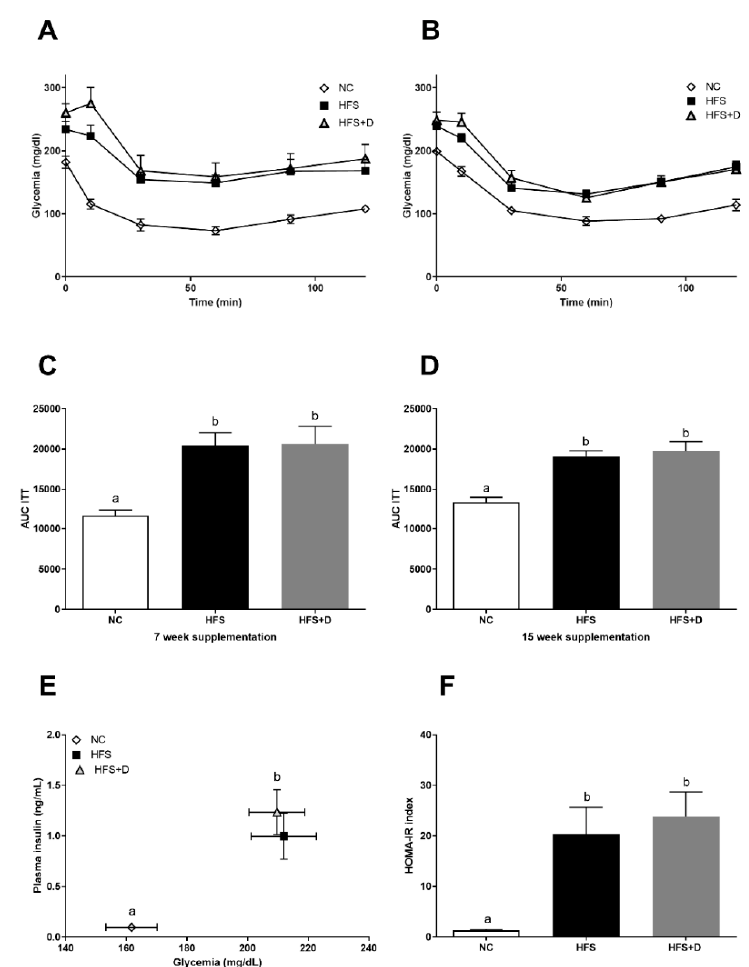
Figure 2. E ff ects of vitamin D (VD) supplementation on glucose homeostasis. ( A ) Glycemic response to insulin injection after 7 weeks of VD supplementation. ( B ) Glycemic response to insulin injection after 15 weeks of VD supplementation. ( C ) Area under the curve (AUC) calculated from the glycemic response curve after 7 weeks of VD supplementation. ( D ) AUC calculated from the glycemic response curve after 15 weeks of VD supplementation. ( E ) Quantification of plasma glucose and insulin at the end of the 25-week protocol. ( F ) HOMA-IR was calculated according to the following formula: (fasting are presented as mean ± SEM; values not sharing the same letter were significantly di ff erent, p <